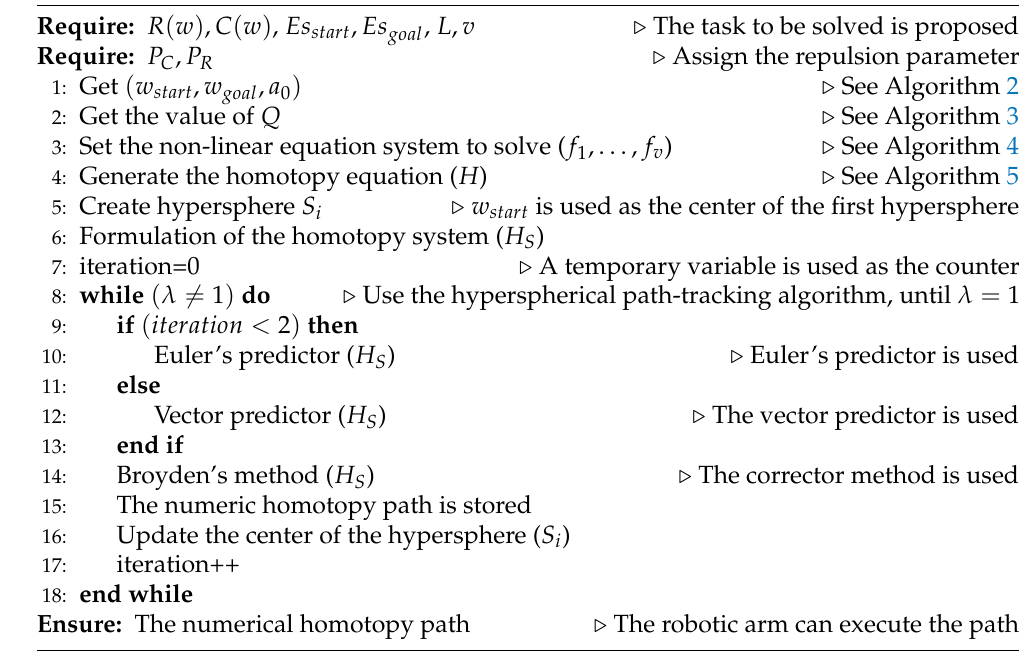
Algorithm 1 HPPM-PRA general procedure.